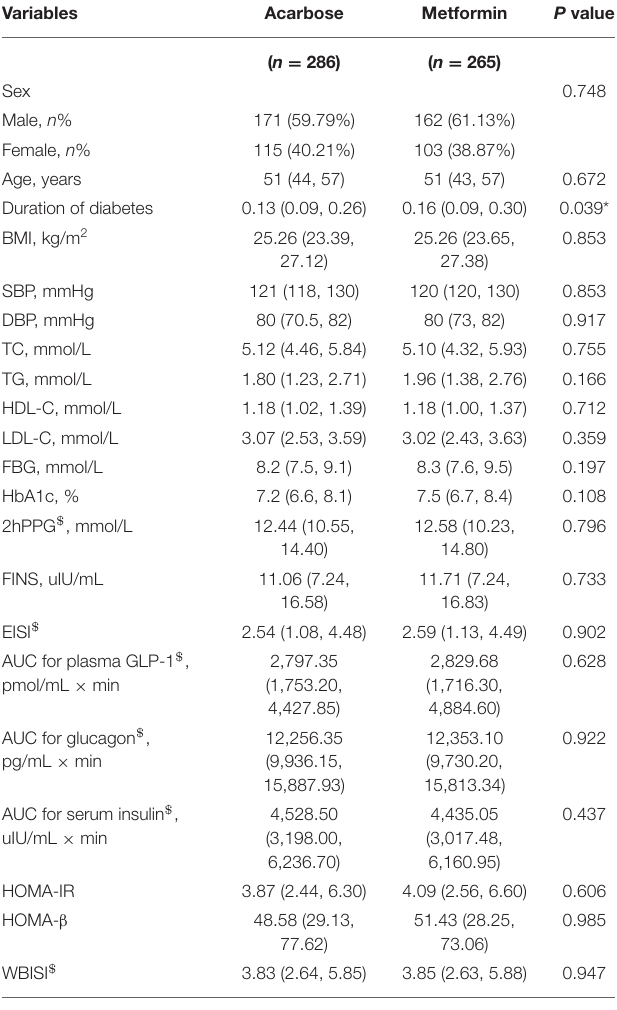
TABLE 1 | Baseline characteristics of patients treated with acarbose or metformin. Variables Acarbose Metformin